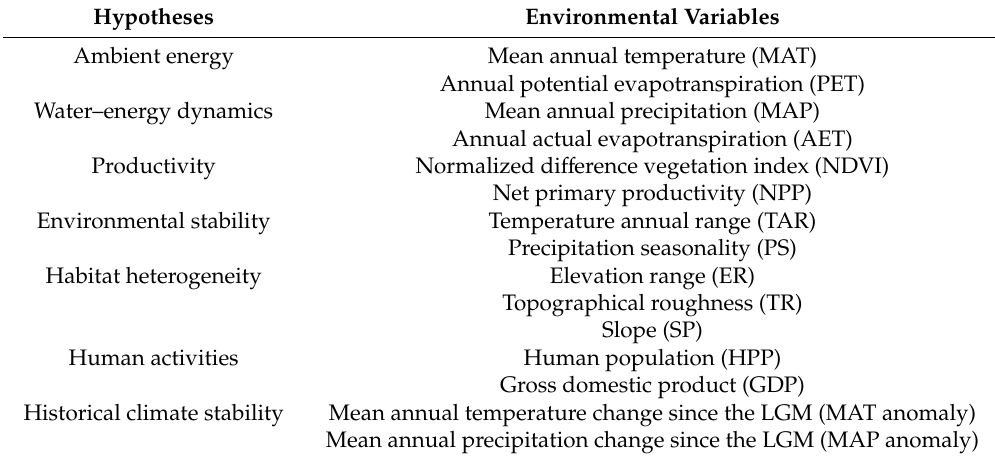
Table 1. The seven species richness hypotheses and their related environmental variables tested in this